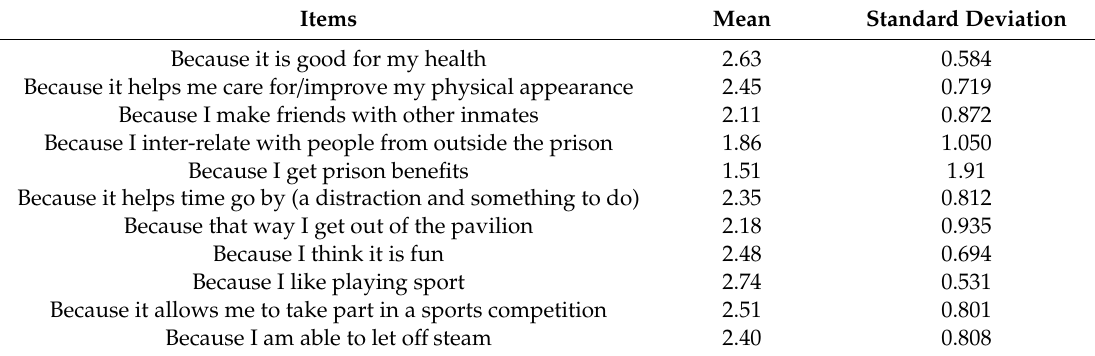
Table 2. Importance respondents gave for continuing to attend the sports